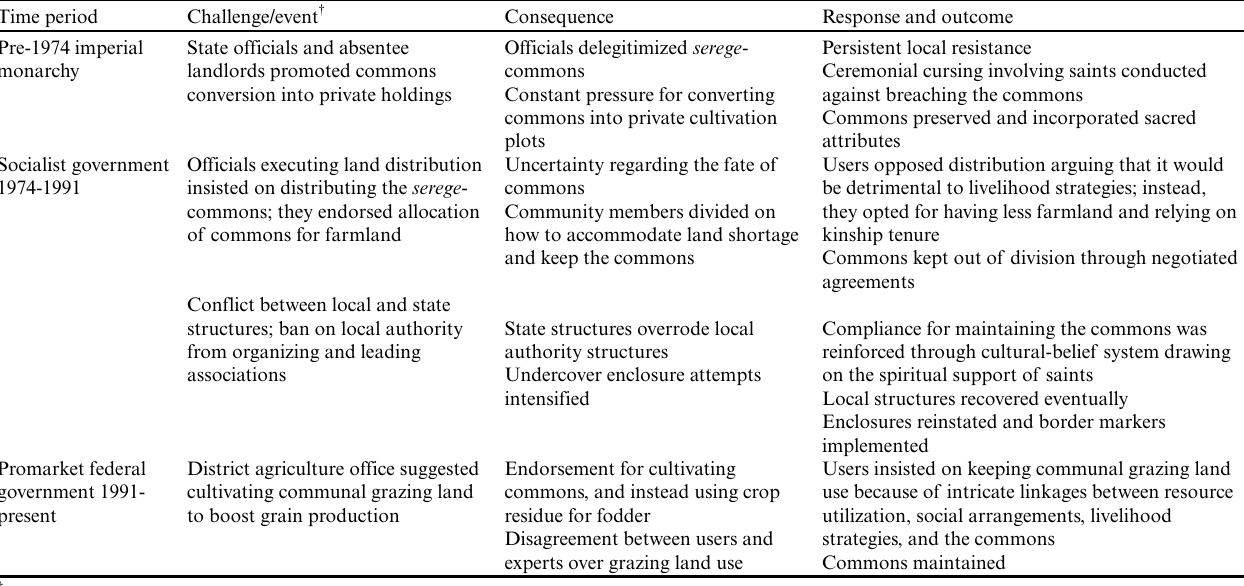
Table 1 . Major challenges facing the local common property resource (CPR) system by time